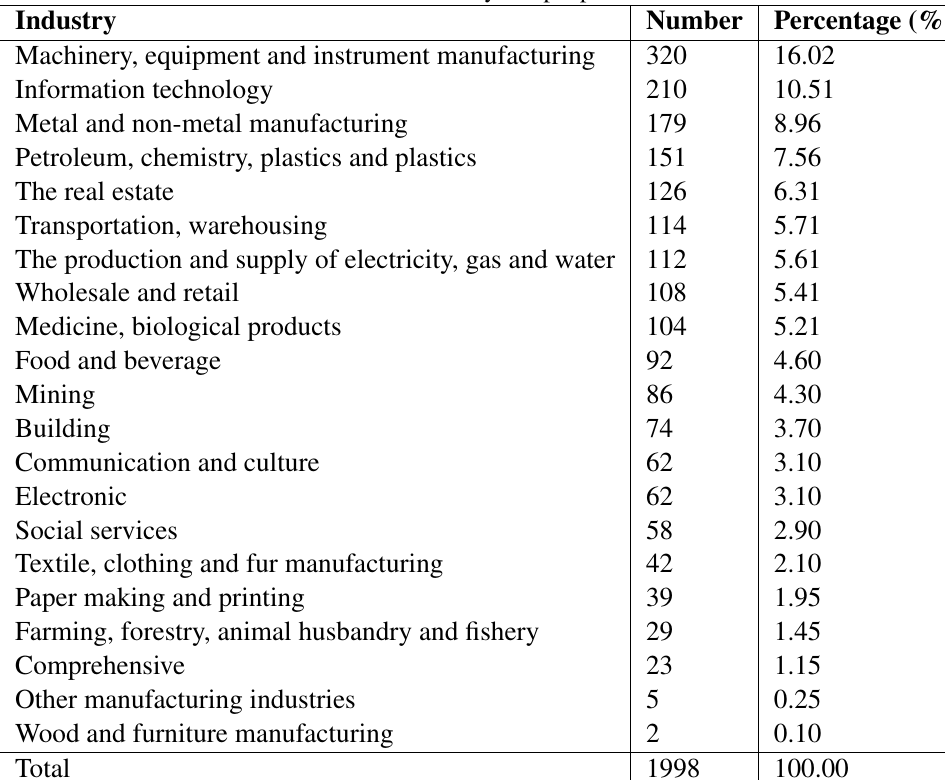
Table 2 Industry sample